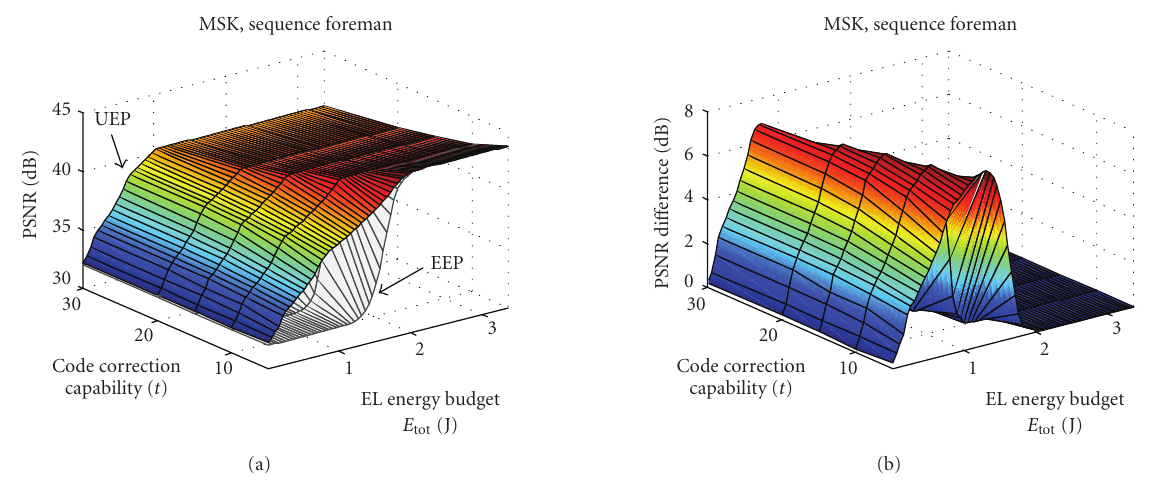
Figure 13: PSNR performance of cross-layer UEP (a) and improvement against EEP (b) versus energy budget and code correction capability of FEC.